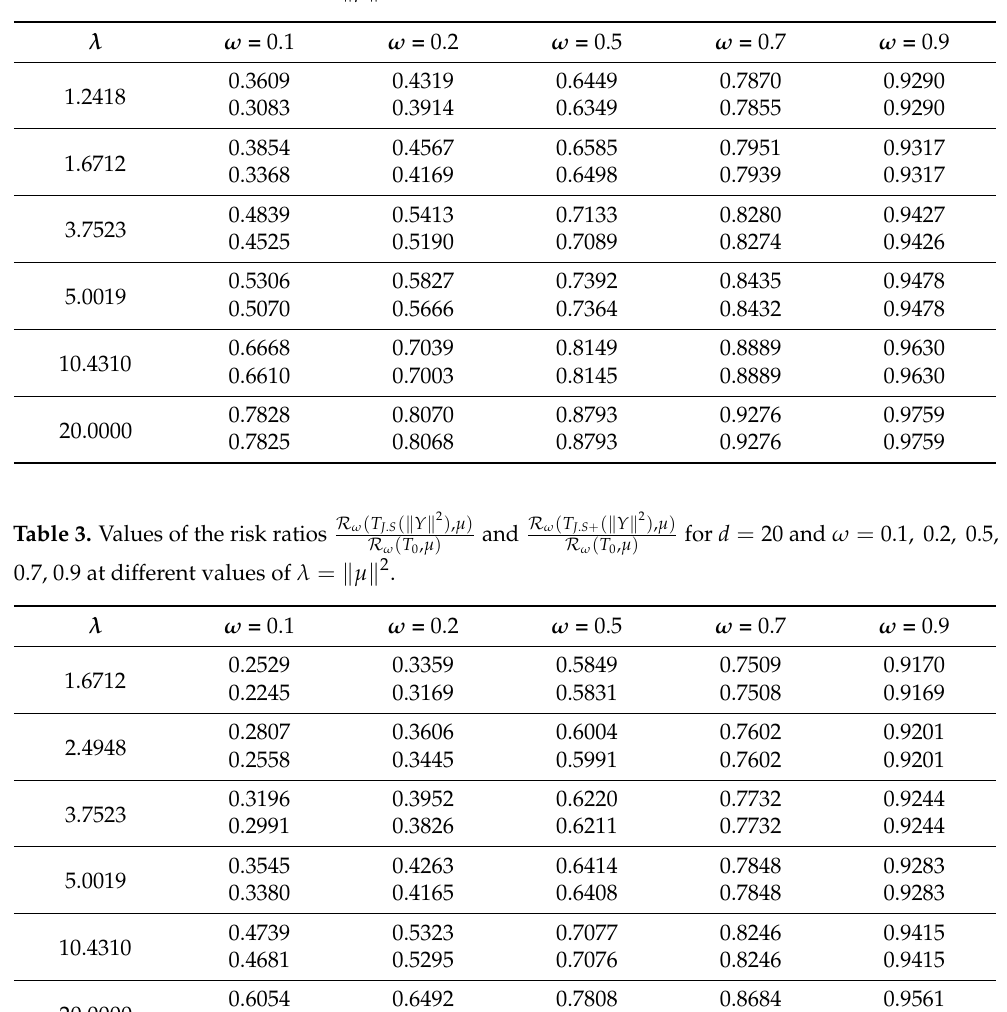
Table 2. Values of the risk ratios